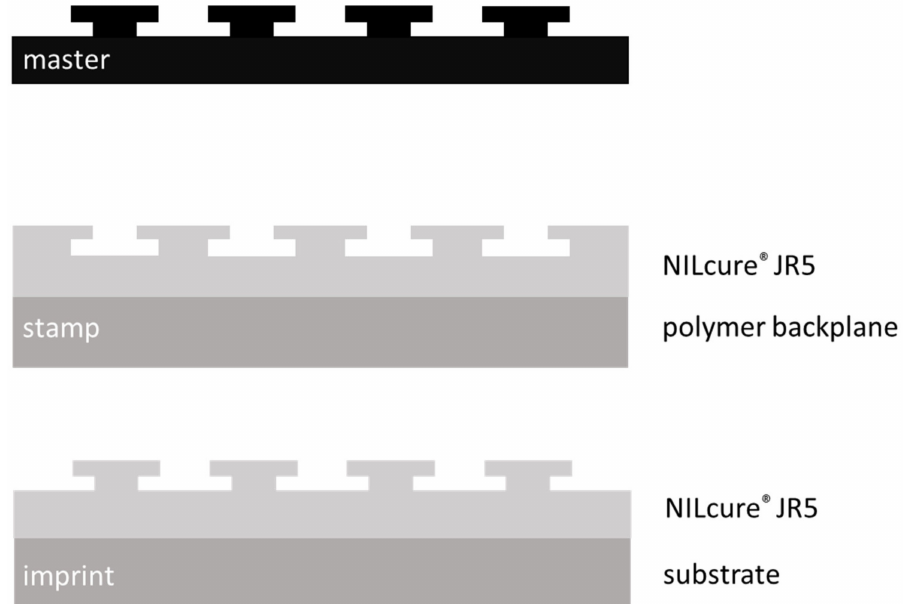
Figure 3. Sample sequence and nomenclature for this work: From a master, a nanoimprint stamp was fabricated (stamp material on backplane), which was then used to create the imprint (imprint material on